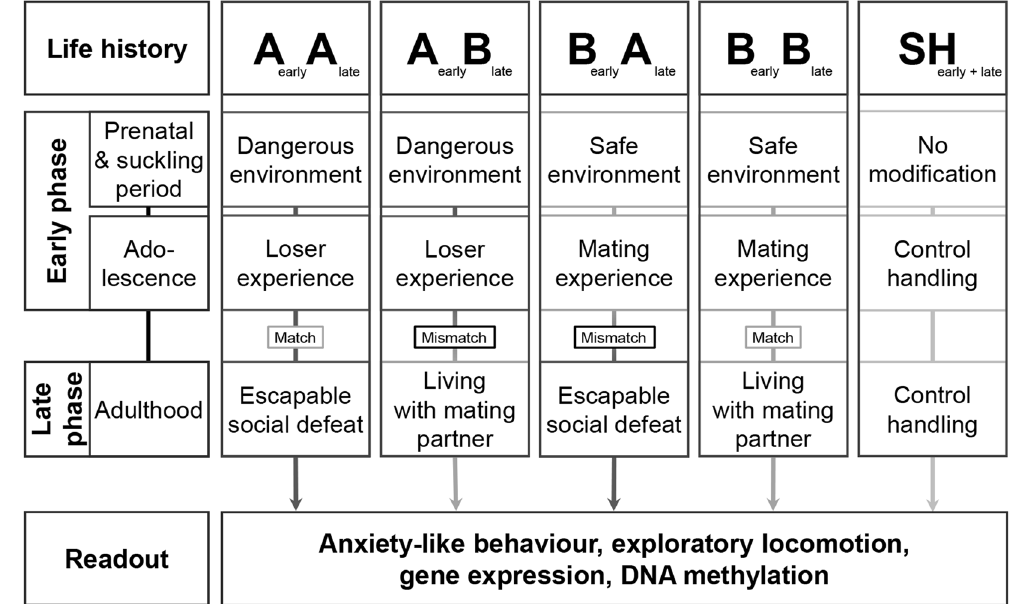
Figure 1. Experimental design. Mice were assigned to one of the four life histories or the sham-handled group. They were provided with either matching or mismatching adverse (‘A’) and/or beneficial (‘B’) conditions from the prenatal phase to adulthood, or a sham-handling (‘SH’) procedure at corresponding times. Anxiety-like and exploratory behaviour were assessed. Afterwards, brains were dissected and subjected to gene expression and methylation analyses (Figure modified after 3, 5